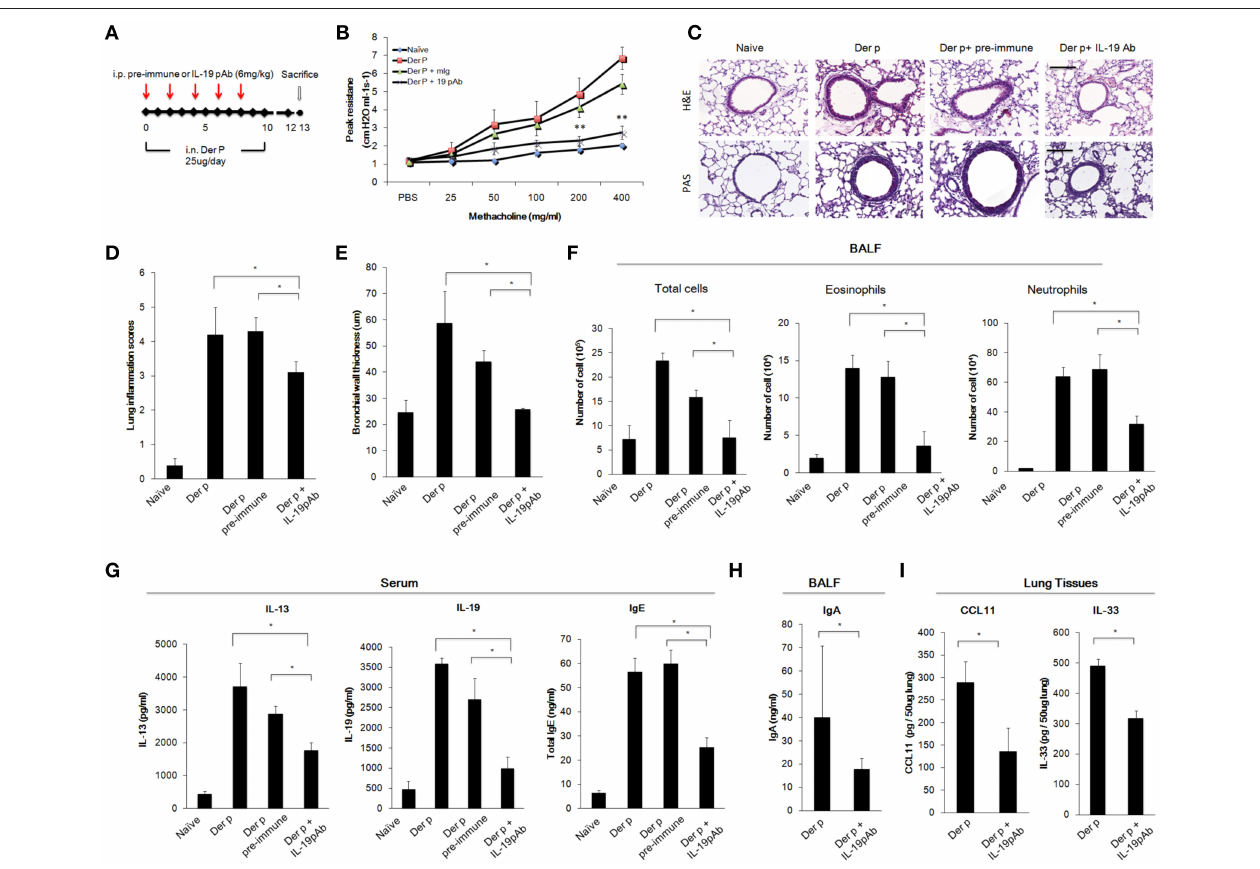
FIGURE 6 | Anti-IL-19 antibody attenuated Der p -induced chronic asthma. (A) Protocol of Der p -induced asthmatic mouse model with anti-IL-19 pAb treatment. C57BL/6 mice were intranasally (i.n.) challenged with Der p (25 µ g/mice/day) for 10 days to induce chronic airway inflammation. Anti-IL-19 pAb (6 mg/kg) or a control pre-immune IgG (6 mg/kg) was intraperitoneally injected into the Der p sensitized mice ( n = 6 in each group). (B) AHR was analyzed in the mice 3 days after the last Der p treatment. Peak AHR was methacholine dose-dependently lower in 51D-treated mice. (C) Hematoxylin and eosin (H&E) staining showed reduced airway thickening and PAS staining showed fewer goblet cell areas in anti-IL-19 pAb-treated mice. (D) Lung inflammation scores of the mice. (E) Airway wall thickness. (F) Number of infiltrated immune cells, eosinophils, and neutrophils in mouse BALF. (G) Serum IL-13, IL-19, and IgE levels in the mice. (H) BALF IgA levels. (I) CCL11 and IL-33 levels in the lung tissues. * P < 0.05, ** P < 0.01 by one-way non-parametric